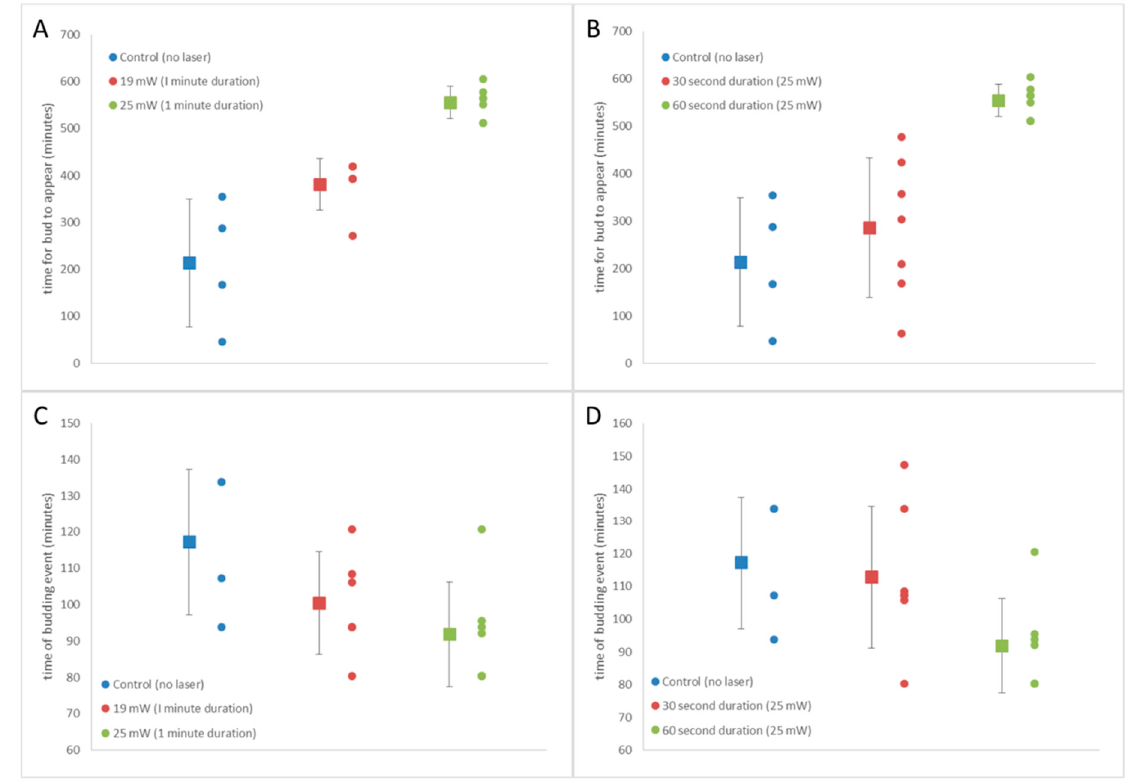
Figure 9. ( A ) Time for S. cerevisiae bud to appear on mother cell surface after tweezing for three laser powers (0, 19 and 25 mW). ( B ) Time for bud to appear for three 25 mW laser durations (0 s, 30 s and 60 s), ( C ) The duration of budding events on single cells, from first observation of bud on surface of mother cell until daughter cell detached from mother cell, for three laser powers (0, 19 and 25 mW), ( D ) duration of budding event for cell exposed to 25 mW laser of different duration (0, 30 and 60 s). Figure 9A,C shows results for cells exposed to no laser beam (Control n = 4), cells exposed to 19 mW for 60 s ( n = 6) and cells exposed to 25 mW for 60 s ( n = 7). The average time to bud after tweezing, with error bars showing standard deviation, is plotted to the left of the data points in Figure 9A, and